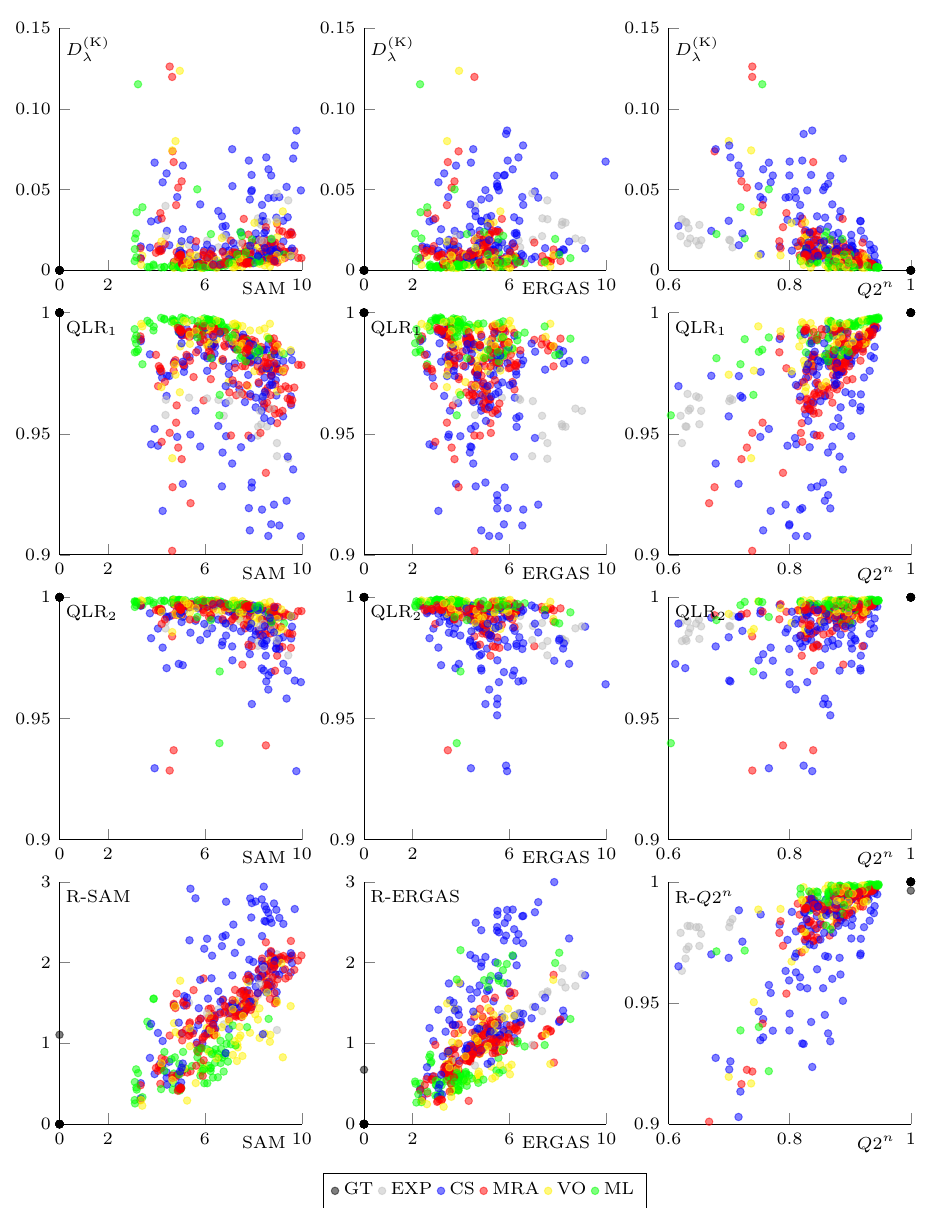
Figure 6. No-reference vs. reference-based indexes’ scores on the aligned WV2 RR dataset. From left to right, SAM, ERGAS, and Q 2 n are selected as reference-based indexes ( x -axis). From top to bottom, D ( K ) , QLR 1 , QLR 2 , and R- are chosen as no-reference indexes ( y -axis). λ M agrees with SAM and